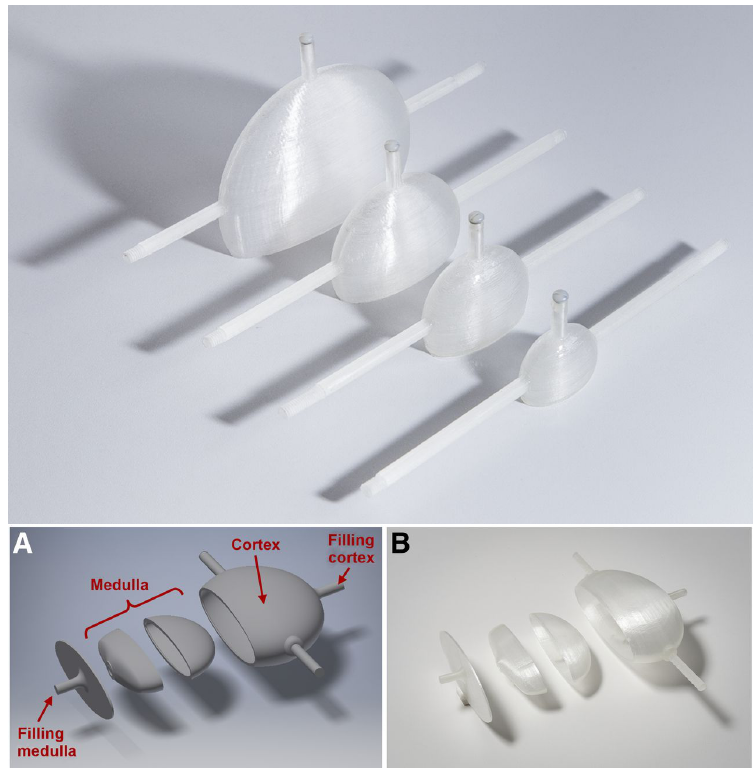
Figure 3. Three-dimensional printing allows for an iterative design process where improvements can be made for a next-generation print. The example shows the single-compartment kidney produced by Tran-Gia et al. [64] (top) and the two-compartment kidney phantom ( A , B ) subsequently produced by the same research group, Tran-Gia et al. [65] (bottom). This research was originally published in JNM by Tran-Gia et al. [64,65]. ©